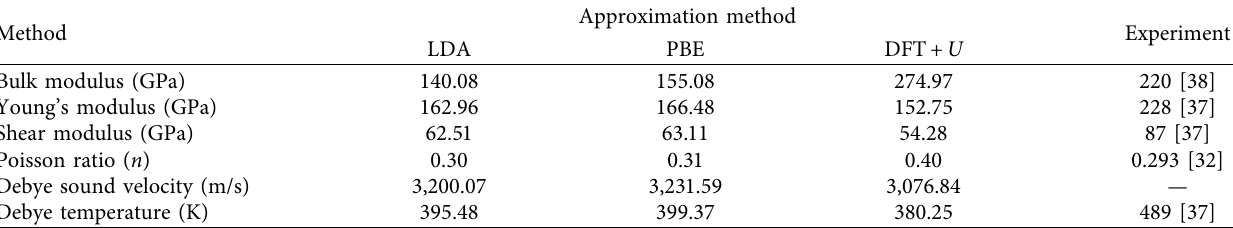
Table 2: Mechanical parameters of CeO